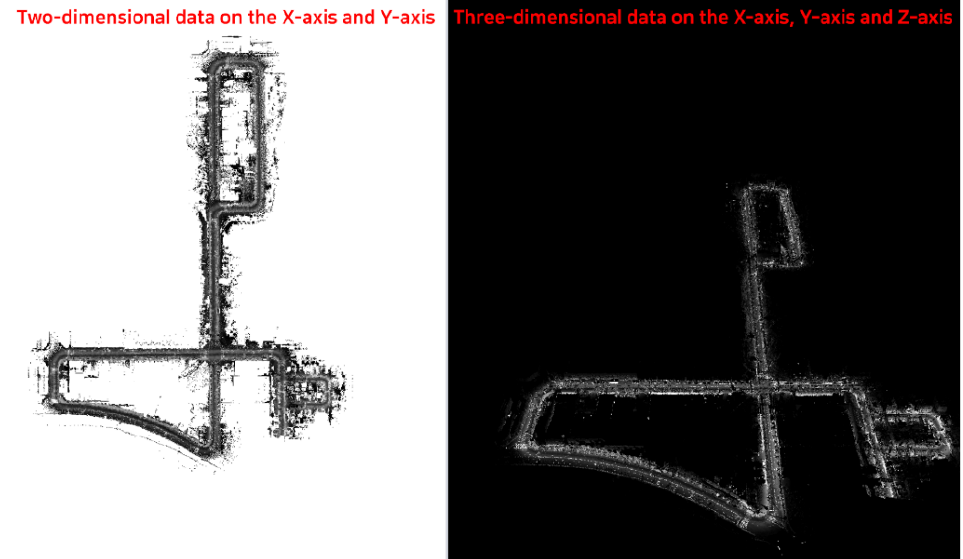
Figure 9. Example of machining data based on the LAS file format.